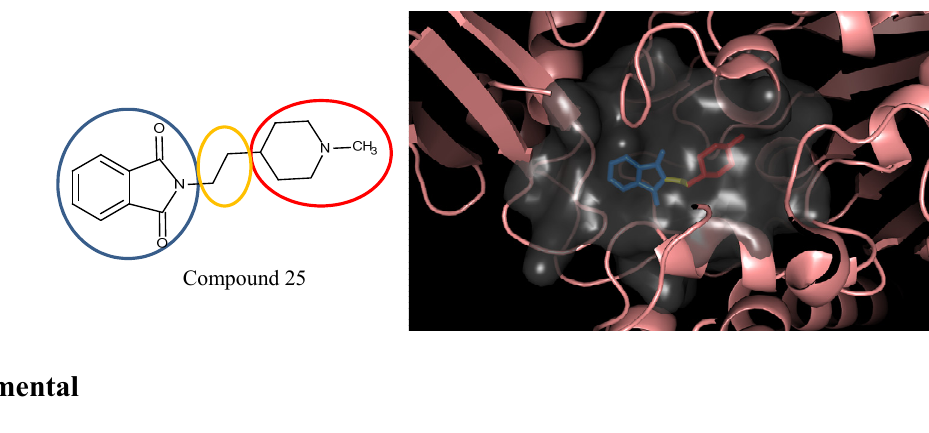
Figure 8. The regenerated compound 25 of E2020 series and bound to AChE crystal structure; three hydrophobic interactions within the ( a ) peripheral pocket, ( b ) catalytic site, ( c ) linker space, and ( d ) hydrogen bond interaction.